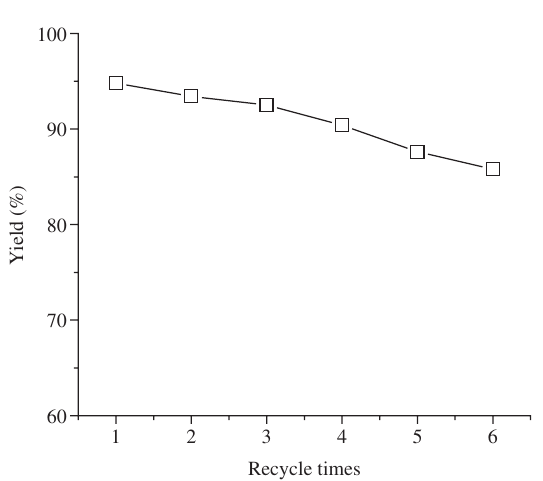
Figure 5 Catalyst recycling in the esterification of caprylic acid with methanol.